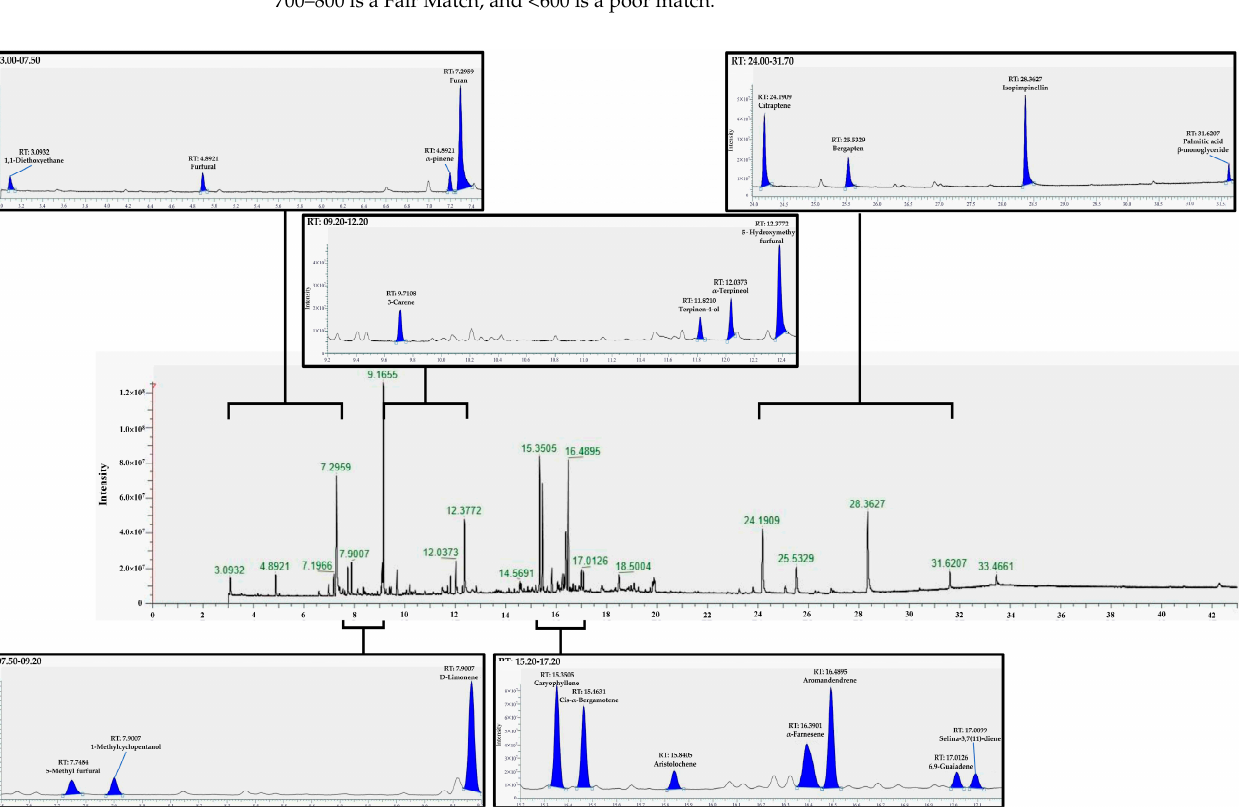
Figure 2. Representative GC-HRMS total ion chromatogram of untargeted metabolome from the ethanolic extract of Lime ( Citrus aurantifolia ) peel.